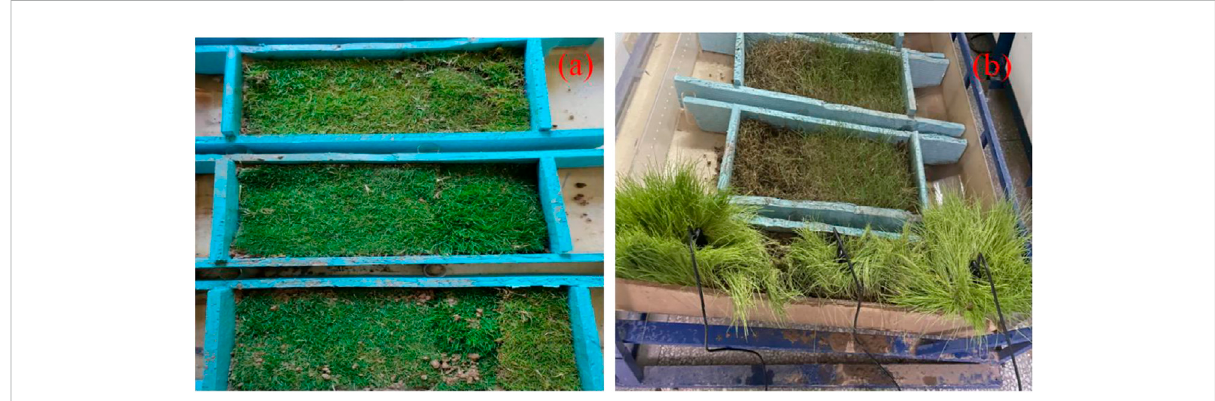
FIGURE 4 (A) Initial growth of slope (B) Layout of slope